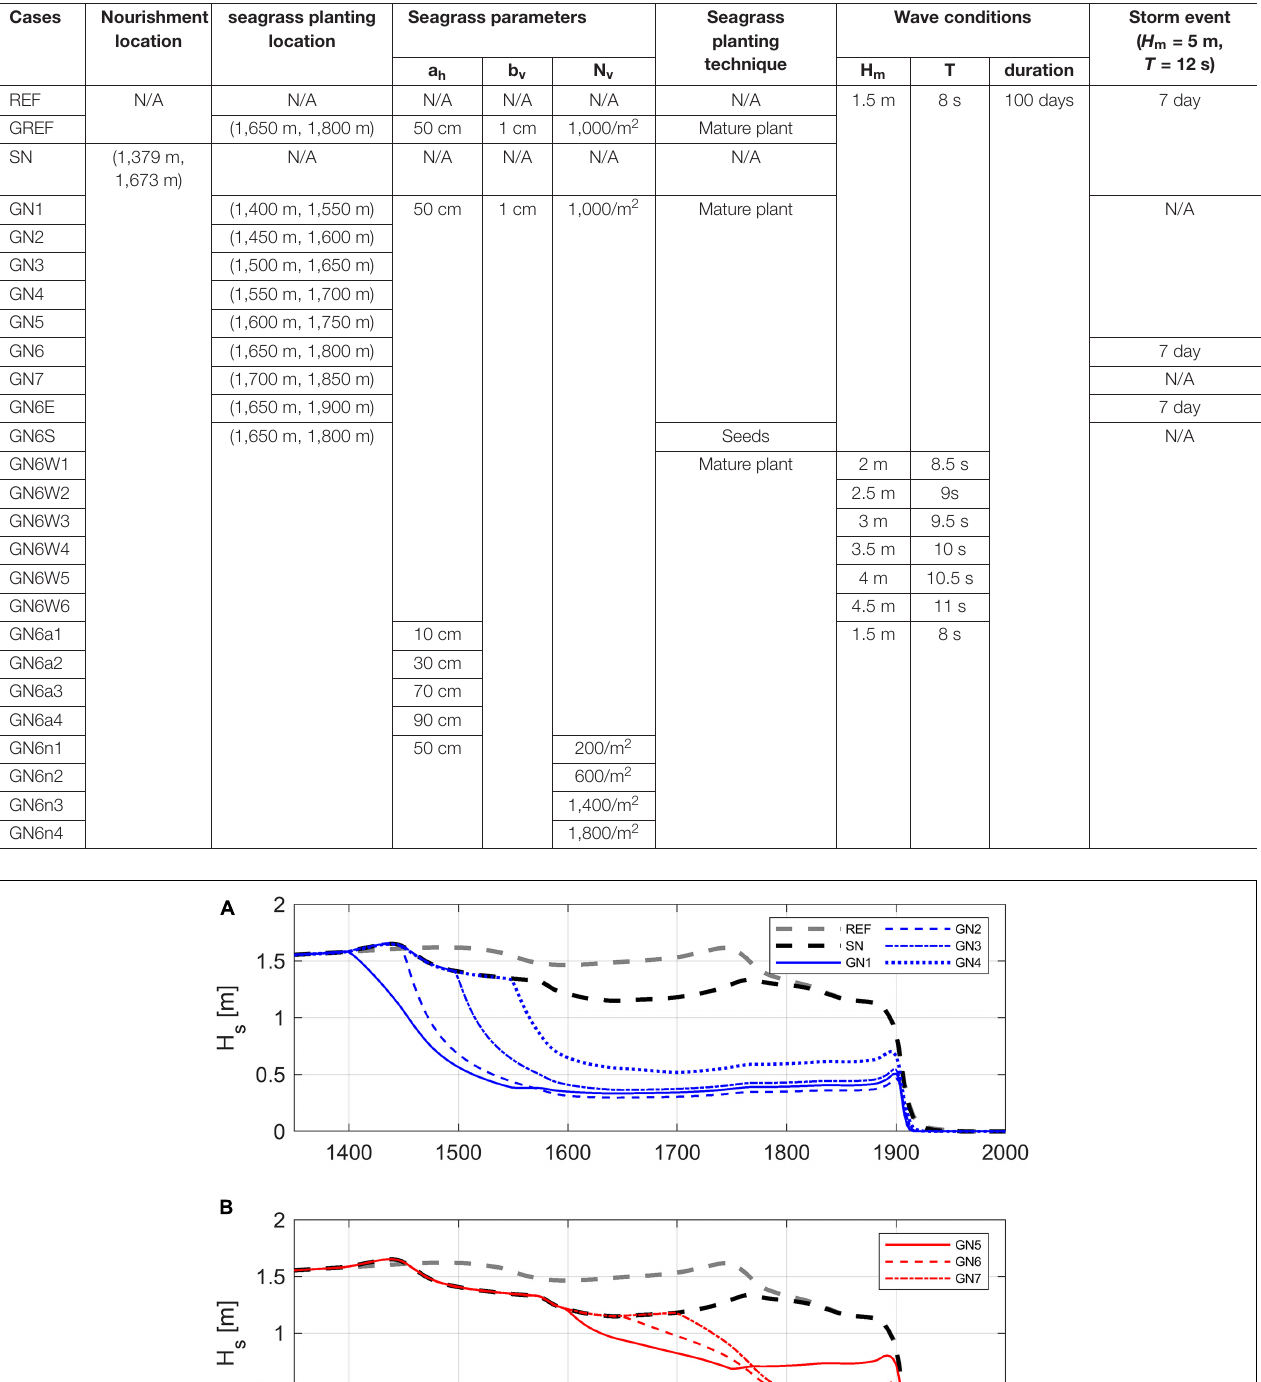
TABLE 1 | Simulation runs tested the impacts of nourishment, the location of a seagrass meadow, the planting techniques, seagrass meadow length, and mild vs. storm waves. Cases